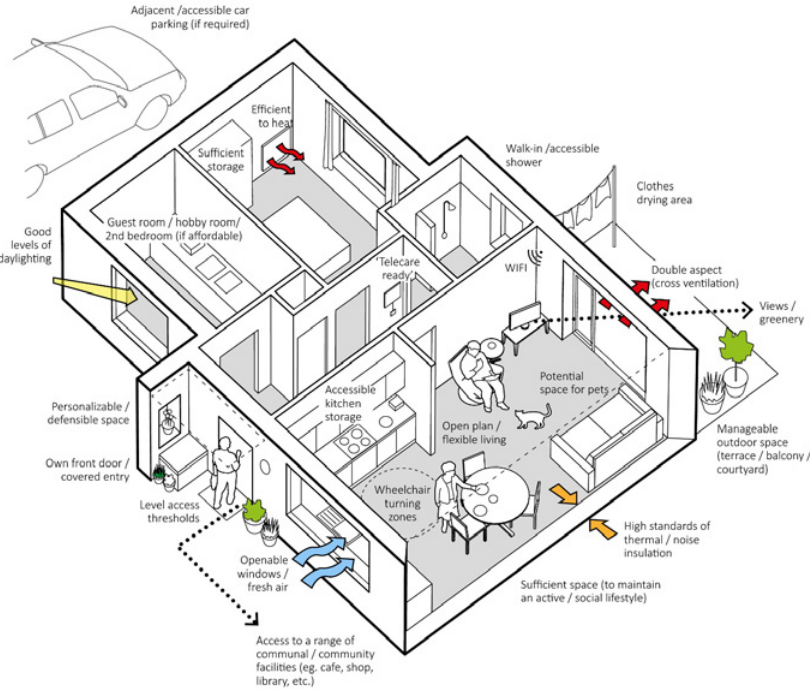
Figure 3. Summary of “HAPPI” design recommendations for accessible dwellings (apartments or bungalows) for downsizers. Image: